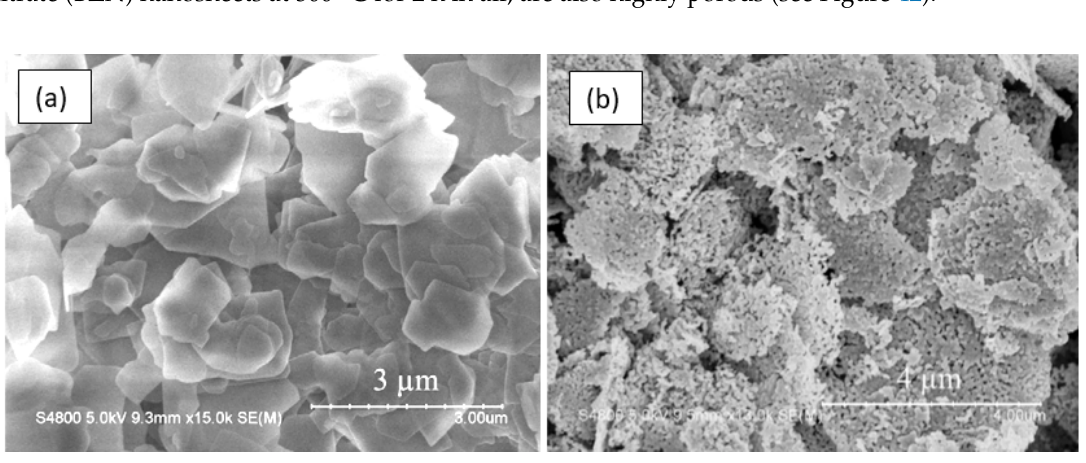
Figure 42. SEM images of ( a ) the as-synthesized BZN nanosheets, and ( b ) porous ZnO nanosheets after BZN nanosheets annealing at 300 o C. The thickness of nanosheets before annealing was in the range of 12-20 nm, and < 15 nm after annealing. Reproduced with permission from Huang et al. [401]. Copyright 2011: Elsevier.